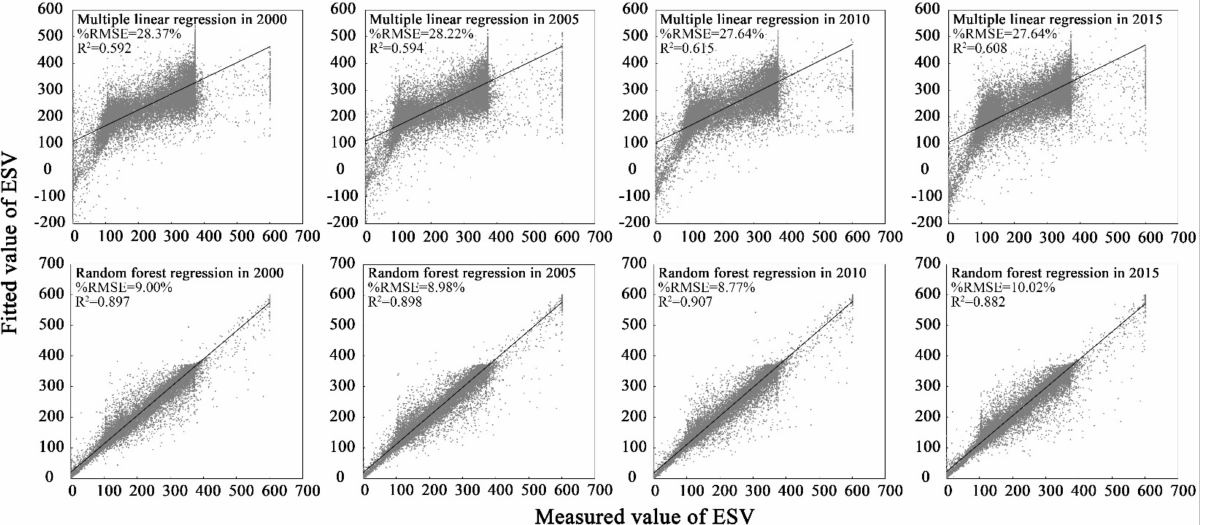
Figure 6. Scatter plot of ESV verification based on multiple linear and RF regression in the Funiu Mountain